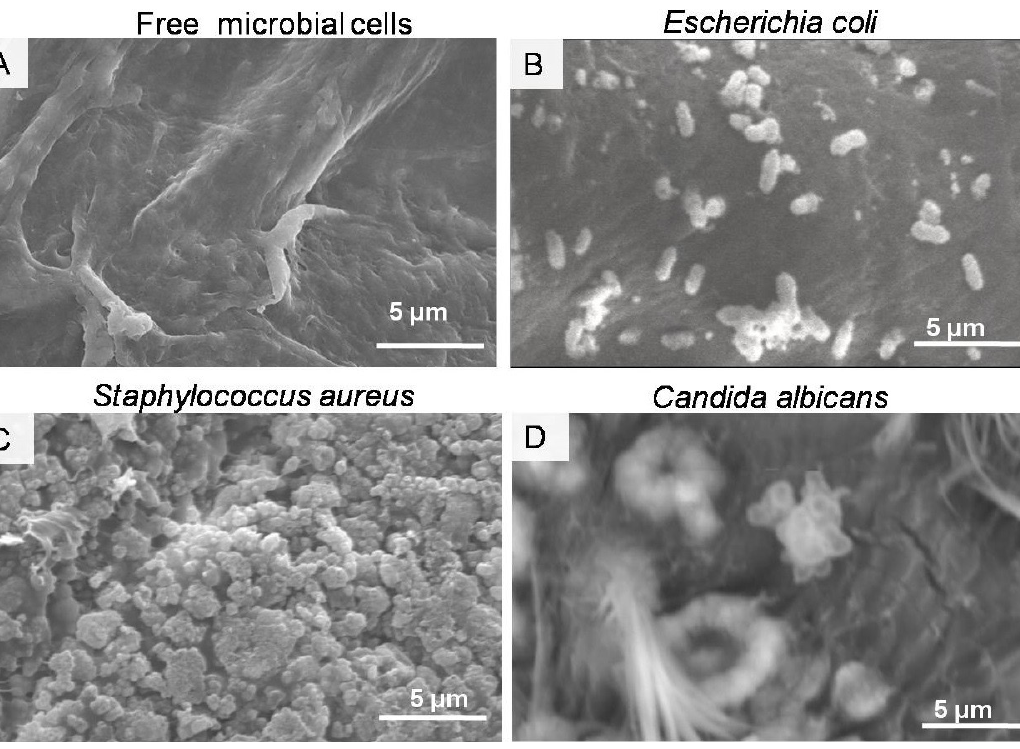
Figure 6. Microbial cells immobilized in PVA matrices. The images shows the presence of bacteria E.coli (b), S.aureus (c) and C. albicans (d) and absence